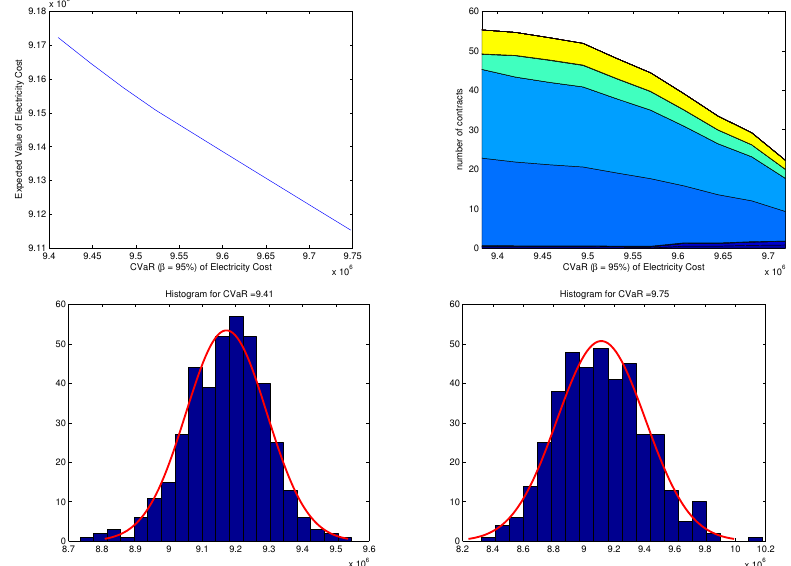
Figure 10. Effect of budget constraint in problem P ret .